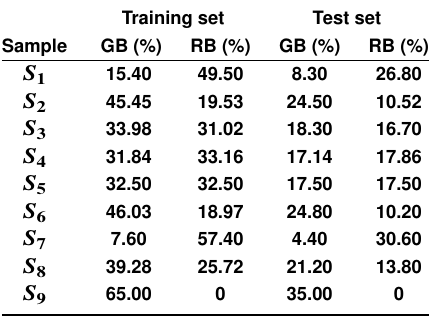
Training set Test